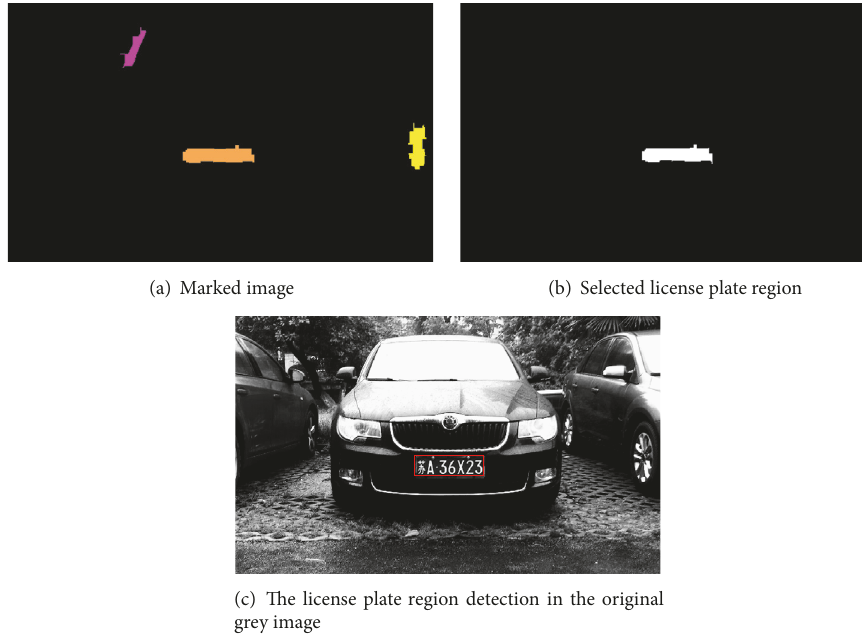
Figure 3: The result of each step in the coarse extraction of the license plate